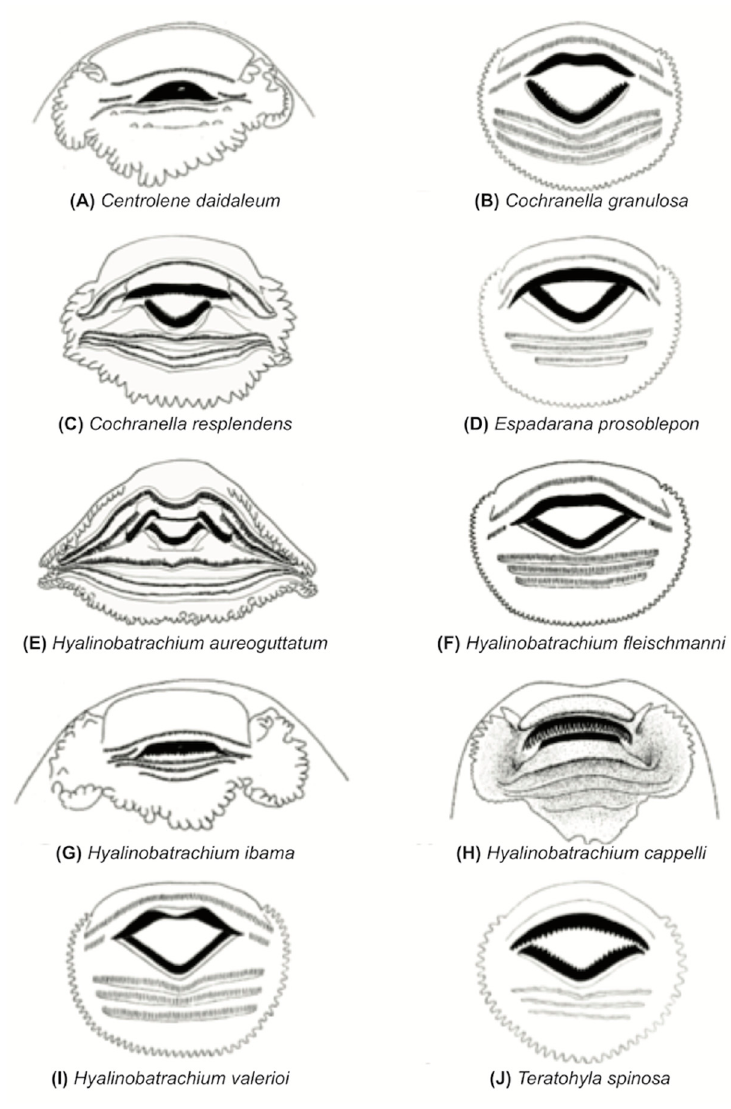
Figure 80. Oral apparatus of different species of Centrolenidae (from Terán-Valdez et al. [167]). Cochranella granulosa and Hyalinobatrachium ibama are in Gosner Stage 24, Cochranella resplendens in Stage 36, H . cappellei in Stage 25, H . aureoguttatum in Stage 35. Gosner stages of the remaining species are not provided in the original descriptions. Figures modified from: ( A , G ) Rada et al. [169]; ( B , D , F , I , J ) Starrett [146]; ( C , E ) Terán-Valdez et al. [167], ( H ) Noonan and Bonett [170].